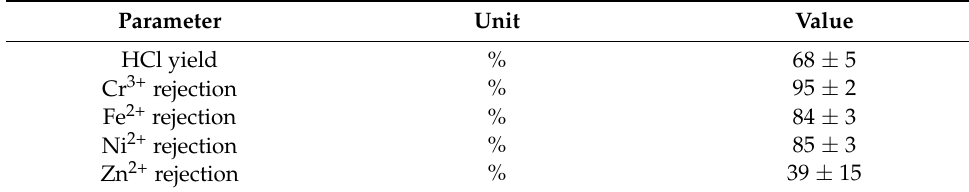
Table 1. Performance parameters of Test 1.